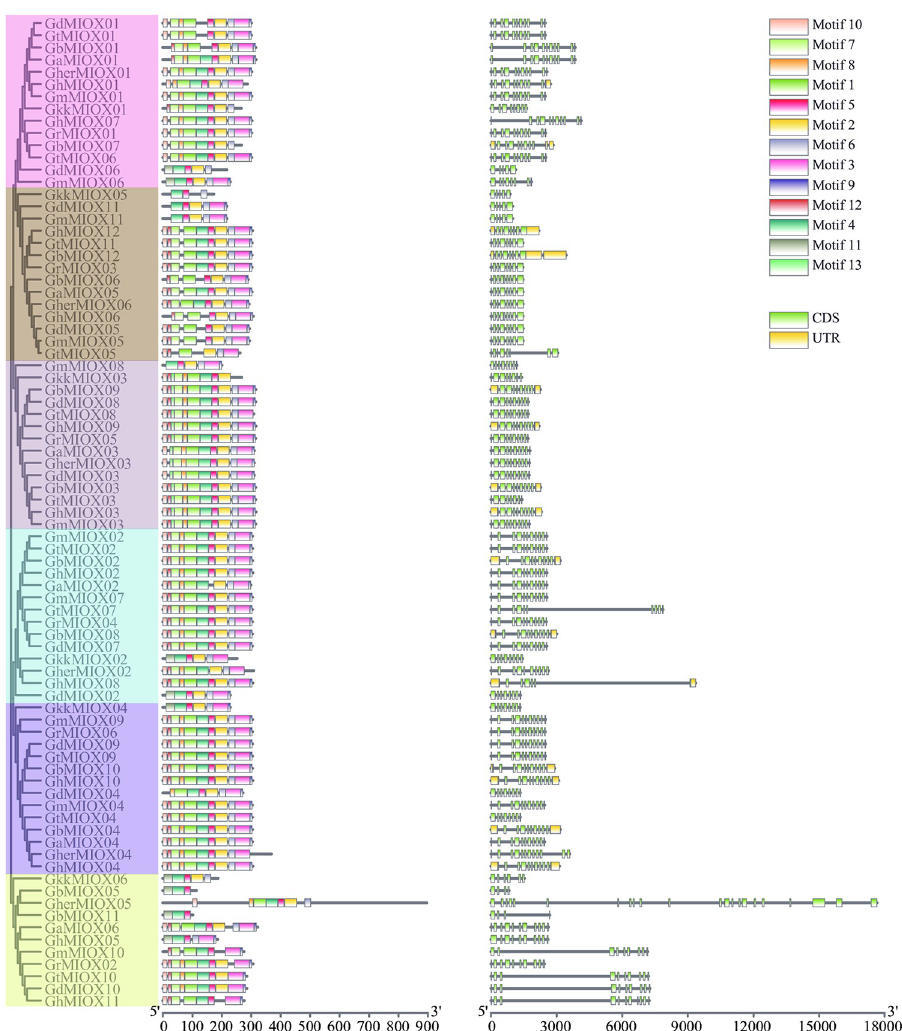
Fig 2. The exon–intron structures and conserved motifs of MIOX. The length of proteins and DNA sequence was estimated using the scale at the bottom, black line indicated the non-conserved amino acid or introns. (a) The conserved motifs of MIOX gene family; (b) The gene structure of MIOX gene